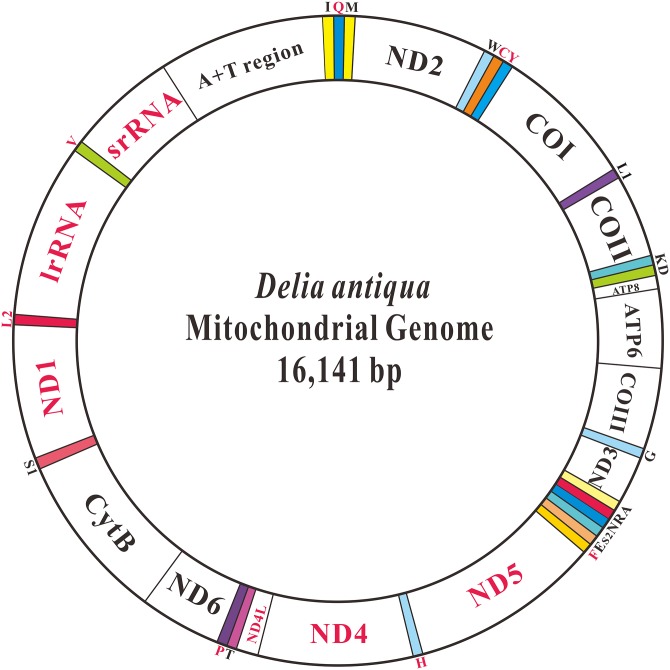
The structure of the mitochondrial genome of Delia antiqua.The color-filled blocks indicate tRNAs, while the un-filled white blocks denote protein-coding genes, rRNA and control regions. The protein-coding genes, rRNA and control regions with black name are located on majority strand, whereas those with red names are on minority strand.